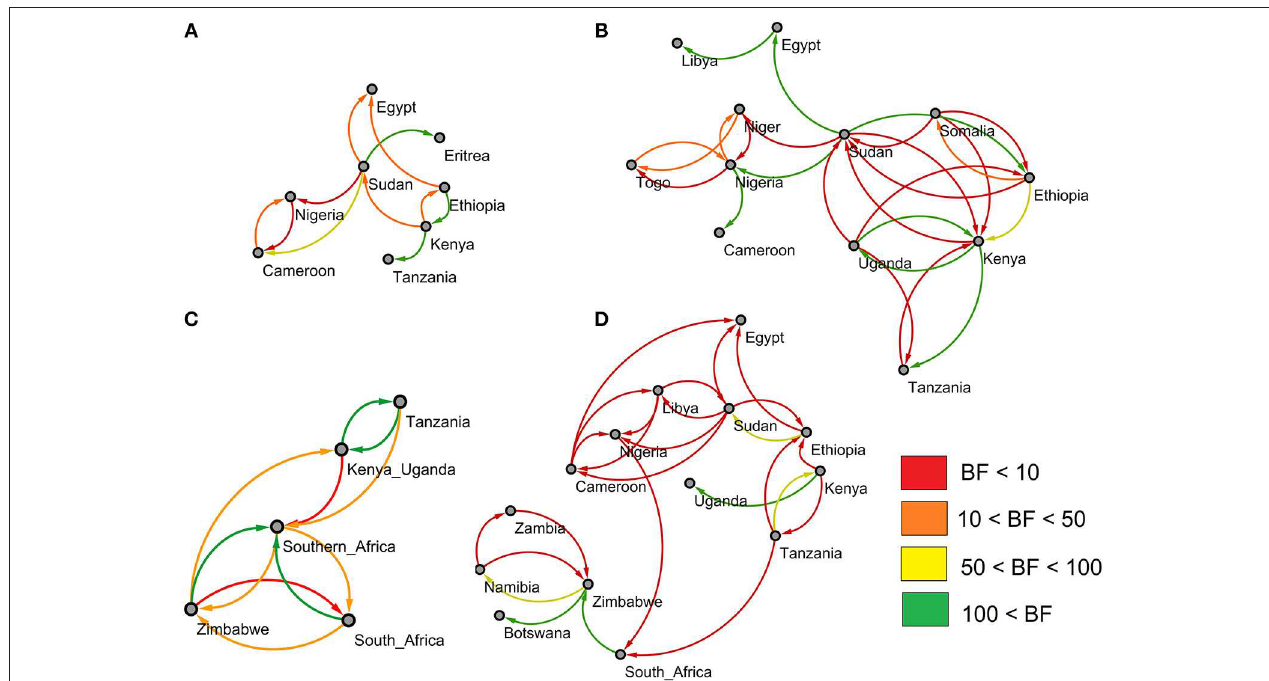
FIGURE 2 | Outputs of the BSSVS analysis for the four studied FMDV serotypes showing the best supported rates of transition between the sampled countries. The edges colors represent the relative strength by which the rates are supported. (A) For FMDV serotype A. (B) For FMDV serotype O. (C) For FMDV serotype SAT1. (D) For FMDV serotype